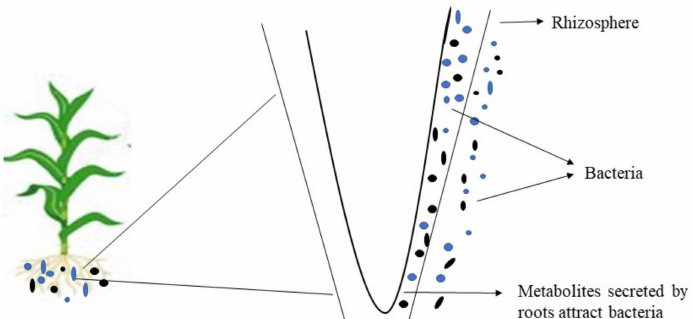
Figure 1. Young roots shape the bacterial population in the rhizosphere community by secreting more organic materials when compared to the older